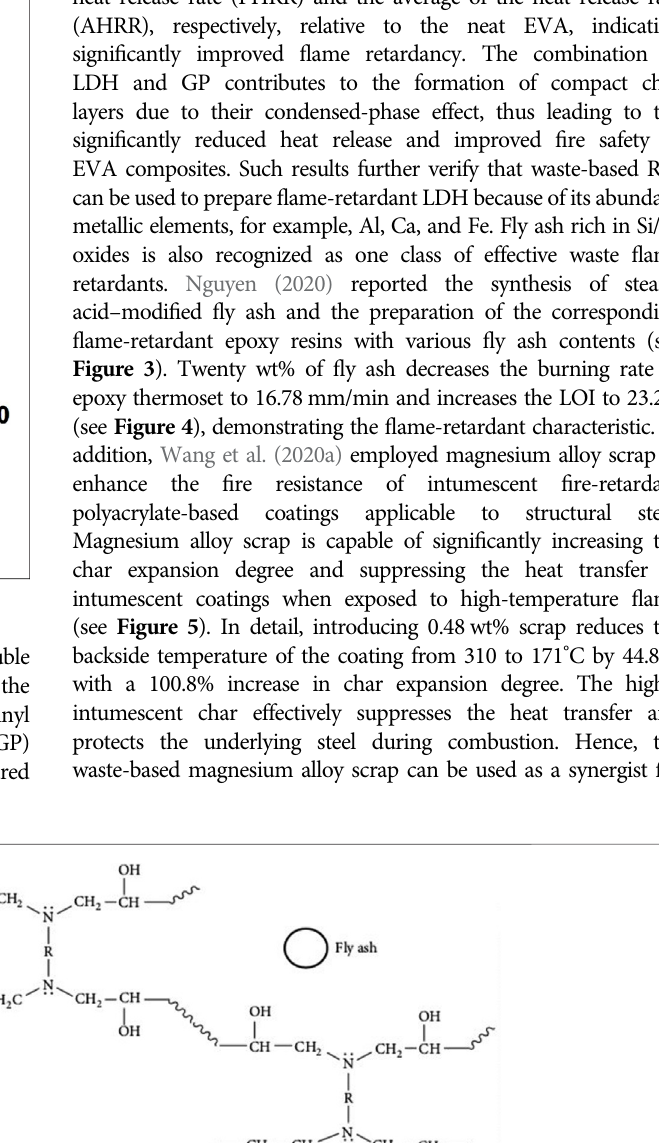
Frontiers in Materials |